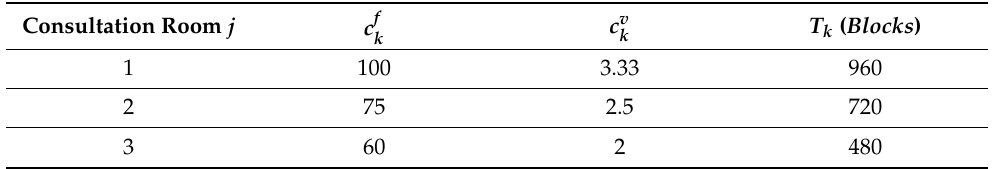
Table 1. Fixed cost of consultation rooms, variable cost per unit service overrun and regular capacity for each consultation room.